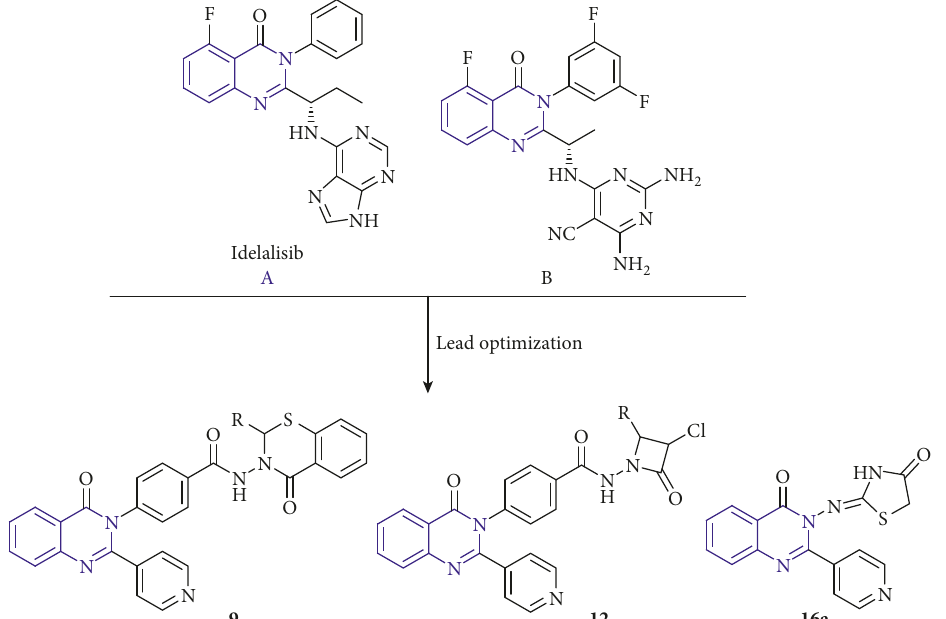
Figure 1: Structures of quinazoline-based PI3K inhibitors and synthesized quinazolines 9 , 12 , and 16a as cytotoxic